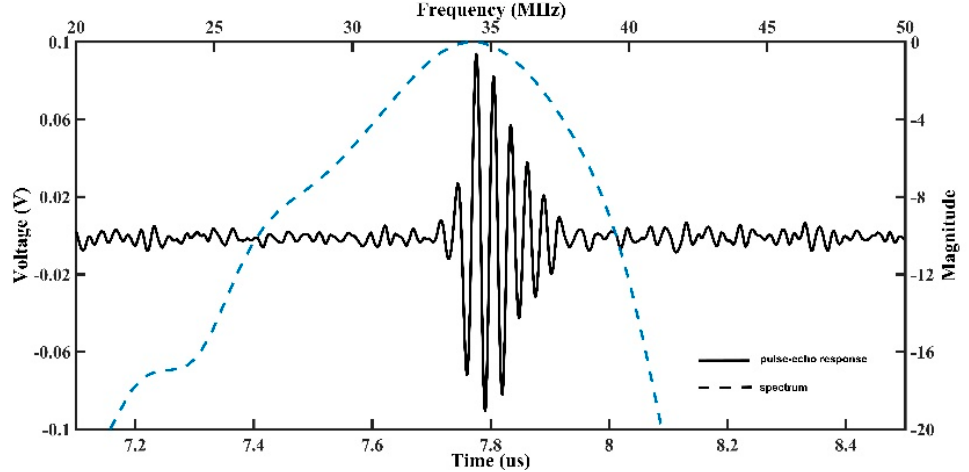
Figure 7. Measured pulse-echo response and Fast Fourier Transform (FFT) spectrum of the BNT-BT transducer.